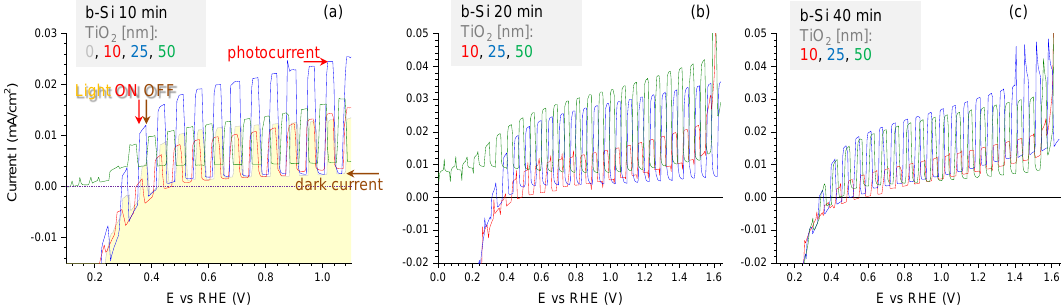
Figure 3. Potentiodynamic scans for the b-Si photoanodes fabricated for ( a ) 10, ( b ) 20 and ( c ) 40 min and coated with 10, 25, or 50 nm TiO 2 , respectively, in NaOH electrolyte under chopped light illumination; x,y-scales are different for a better